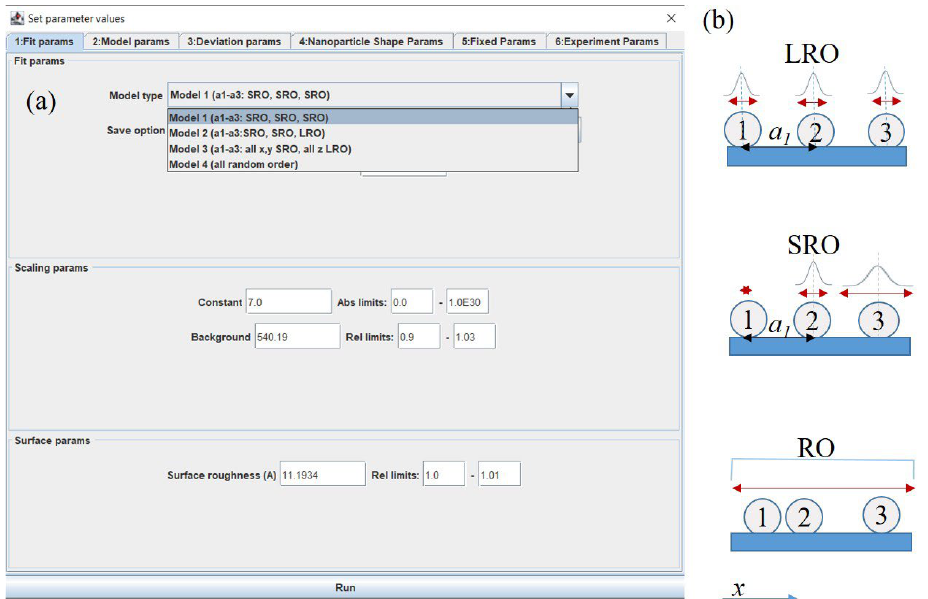
Figure 5. ( a ) Window for setting the parameter values that appears for the ‘ Vis Guess ’ option in the main window. The opened window contains six tabs: Fit, Model, Deviation, Nanoparticle shape, Fixed params and Experiment params . The chosen tab allows for setting the model type, scaling, and surface parameters. ( b ) Scheme of possible ordering types along one of the basis vectors ( a 1 ) of the NP lattice: long range ordering (LRO), short - range ordering (SRO) , and random ordering (RO).